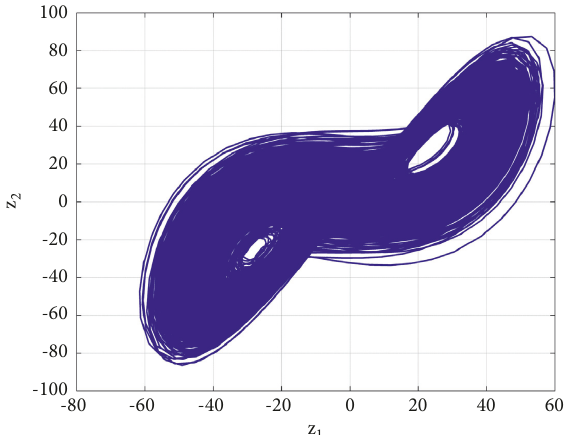
Figure 7: A hyperchaotic attractor of the model (1) when a � 25 and ( b, c, d ) � ( 8 , 90 , 6 )